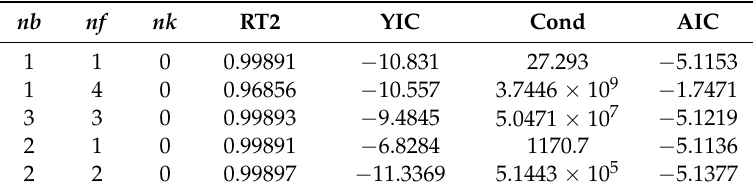
Table 2. SRIV identification algorithm factors.